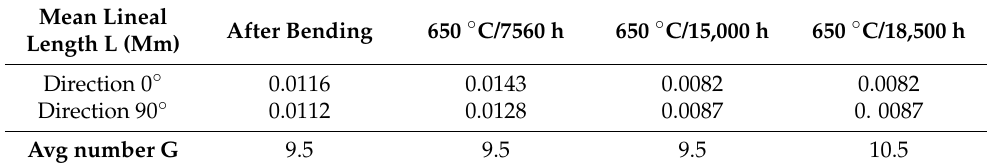
Table 3. Mean lineal length L (mm) of the grain intercept represented by the grain size number G. Mean Lineal